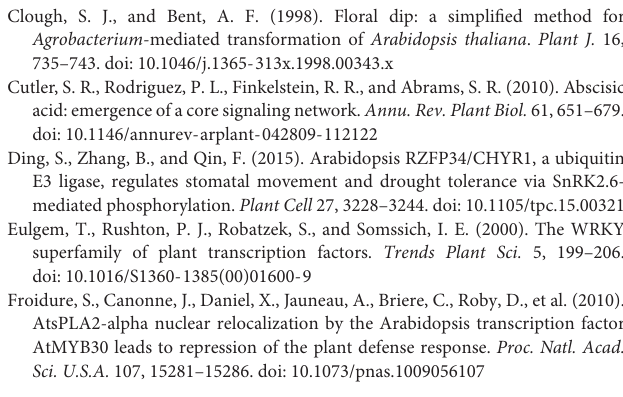
FIGURE S1 | Sequence logo drawn based on the alignment of amino acid sequences of AP2/ERF domain. The overall height of the stack indicates the sequence conservation at that position, while the height of symbols within the stack indicates the relative frequency of each amino at that position. FIGURE S2 | Comparisons of the deduced amino acid sequence of the CaAIEF1 protein with Capsicum annuum proteins. Identical amino acid residues are highlighted in black, and the upper line indicates the VIGS target region. FIGURE S3 | Expression of CaAIEF1 . (A) The expression pattern of the CaAIEF1 gene was analyzed in the leaves of pepper plants after treatment with ethylene (10 µ L/L). (B) The expression pattern of the CaAIEF1 gene was analyzed in the leaves of pepper plants in developmental stages. The pepper Actin1 gene was used as an internal control. FIGURE S4 | Expression of the CaAIEF1 gene in transgenic Arabidopsis plants. Reverse transcription-polymerase chain reaction (RT-PCR) analysis of CaAIEF1 expression in transgenic Arabidopsis plants overexpressing CaAIEF1 . The expression level of CaAIEF1 was analyzed in the leaves of 4-week-old CaAIEF1- OX Arabidopsis plants. The Arabidopsis Actin8 gene was used as an internal control. FIGURE S5 | Increased sensitivity of CaAIEF1- OX transgenic Arabidopsis plants to abscisic acid (ABA) during post-germinative stage. (A) Root elongation of wild type and transgenic plants exposed to ABA after germination. Three-day-old seedlings grown on 0.5X MS were transferred to 0.5X MS containing 0, 10, or 30 µ M ABA. After 9 days, the representative images were taken. (B) Growth of wild-type and transgenic plants exposed to ABA after germination. Two-day-old seedlings grown on 0.5X MS were transferred to 0.5X MS containing 0 or 5 µ M ABA. After 4 days, the representative images were taken, and the cotyledon greening in each line was measured. Data represent the mean ± standard error values obtained after evaluating 50 plants from three independent experiments. Different letters indicate significant differences (ANOVA; P <